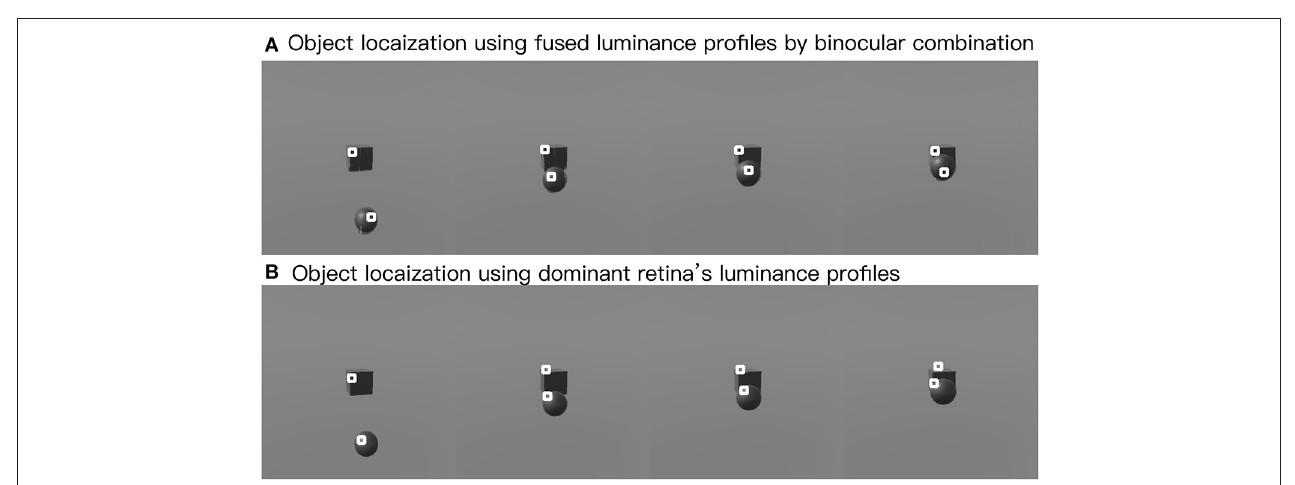
FIGURE 9 | Effects of clustering in binocular combination. The upper row shows the clustering after binocular combination (A) , and the lower row shows the clustering using the dominant eye’s luminance profile (B) . White circles mark the cluster centers.